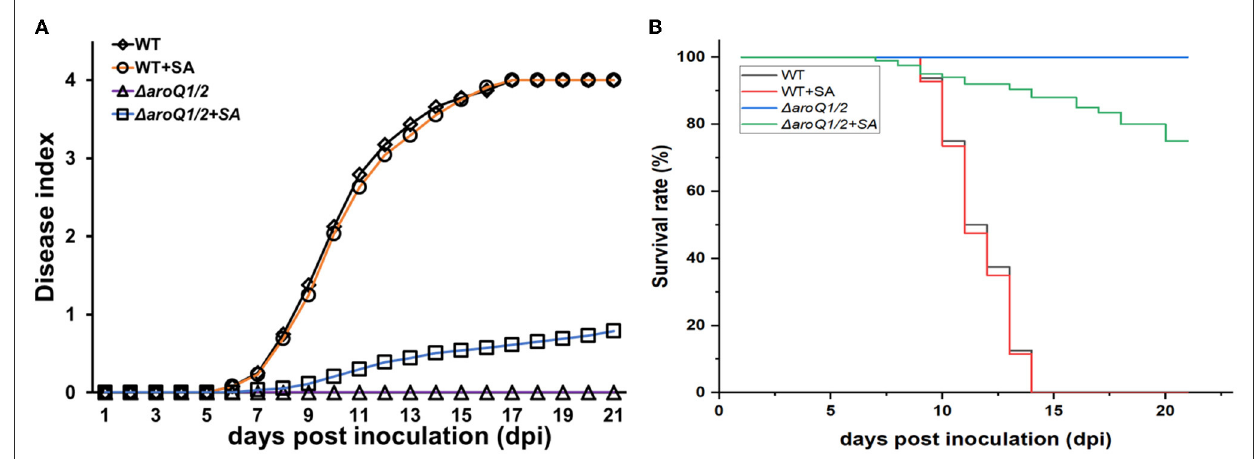
FIGURE6 Restoration of SA on the virulence of the aroQ1/Q2 double mutant on tomato cutting seedlings with petiole-cutting inoculation method. (A) Virulence assay with the disease index and (B) surviving curves. WT, RK5050 (OE1-1, popA-lacZYA ); 1 aroQ1/2, RQ5951 (RK5050, 1 aroQ1/2 ); + SA, SA supplementation. For SA restoration, tomato cutting seedlings were soaked in one-quarter diluted minimal medium with SA at 300 µ M for 4 days and subsequently inoculated with the petiole-cutting inoculation method. The disease index was scored on scales from 0 to 4, and surviving curves were performed with two levels of no wilting symptoms (disease index below 3) and completely wilted (disease index equal to or higher than 3). Mean values of all experiments were averaged with SD, while it was not presented in figures due to the consideration of esthetic appearance. Statistical significance was assessed using a post-hoc Dunnett’s test following